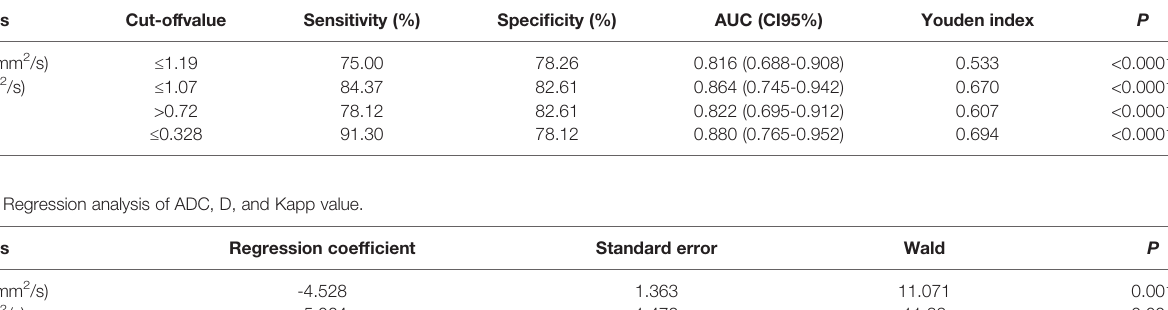
TABLE 3 | Diagnostic ef fi ciency of quantitative parameters. Parameters